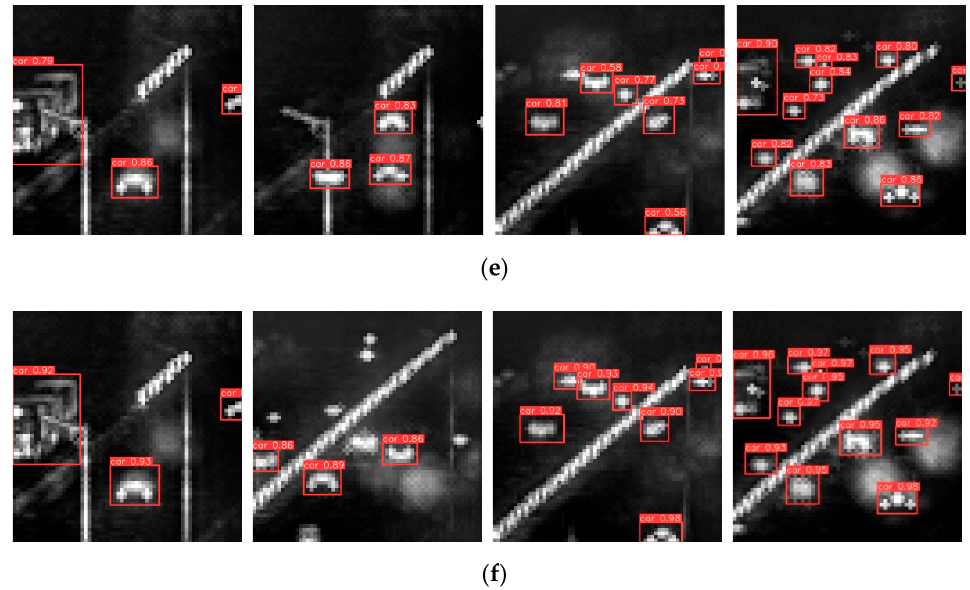
Figure 17. Test results of four methods. ( a ) Faster R-CNN; ( b ) SSD; ( c ) RetinaNet; ( d ) CenterNet; ( e ) YOLOX; ( f ) Ours.